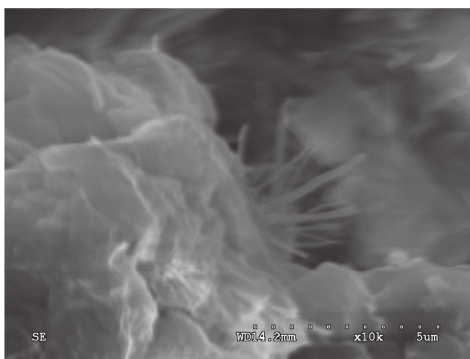
Figure 14: The soil of curing 14d and being magnified 10000 times.